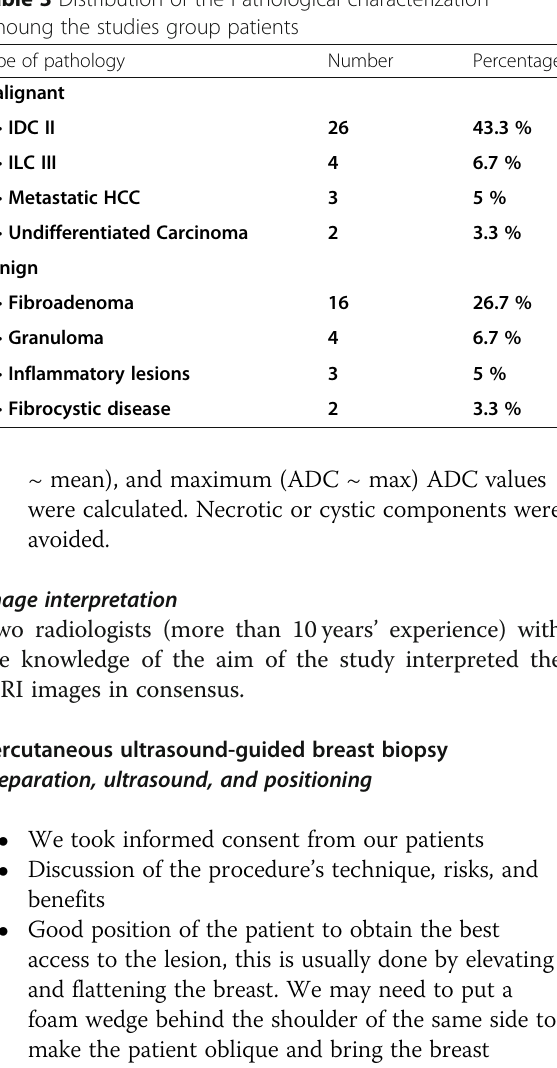
Table 5 The relation of the type of diffusion and the